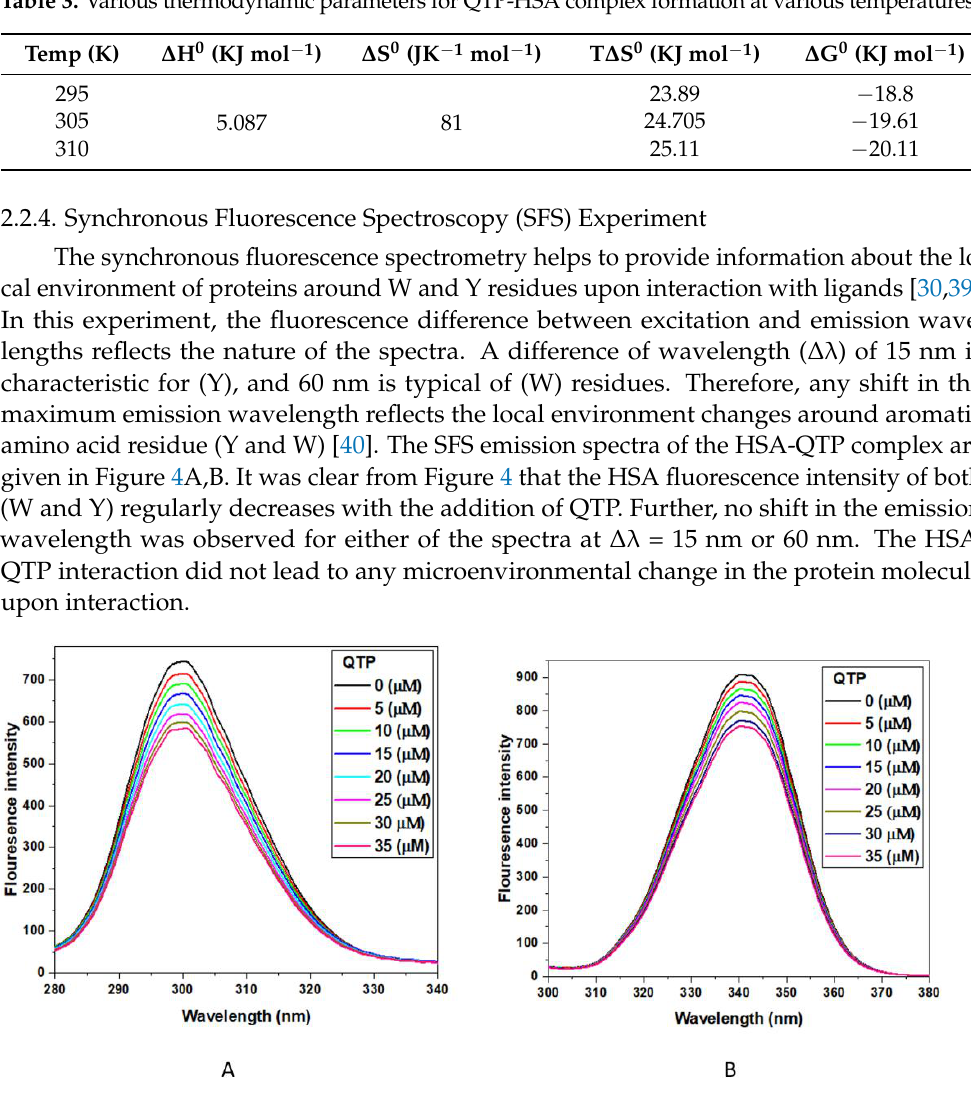
Figure 4. Synchronous fluorescence spectra at ∆ λ = 15 nm ( A ) and ∆ λ = 60 nm ( B ) of HSA (5 µ M) in the absence and presence of increasing concentrations of QTP (0-35 µ M). At ∆ λ = 15 nm (for Y), the excitation wavelength of HSA was fixed at 240 nm, and the emission range was 255–400 nm, whereas at ∆ λ = 60 nm (for W), the excitation wavelength was taken at 240 nm and the emission range was 300–400 nm.